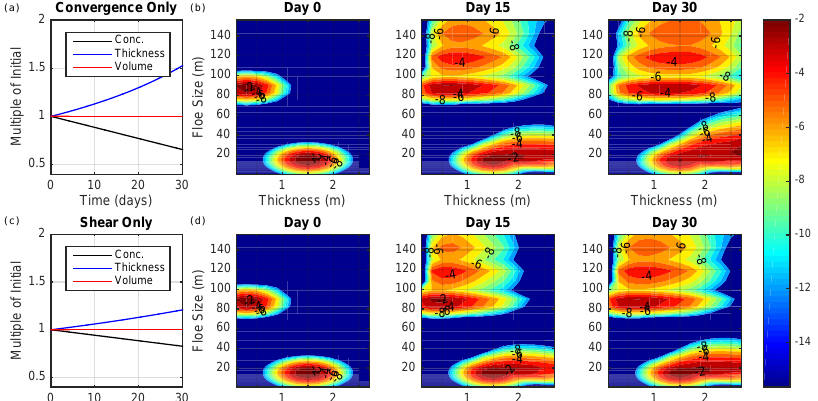
Figure 4. Results of two simulations of the floe size and thickness distribution forced with fixed ice-flow strain rates and only mechanical in- teractions. (a) Ice concentration, mean thickness, and ice volume for 1 month of fixed shear, with no convergence. Time series are normalized by their initial values. (b) The base 10 logarithm of the FSTD at days 0, 15, and 30 for the run with only shear. The color bar corresponds to the base 10 logarithm of the FSTD, contour intervals are powers of 10. (c, d) Same as (a, b) for 1 week of fixed convergence with no shear.